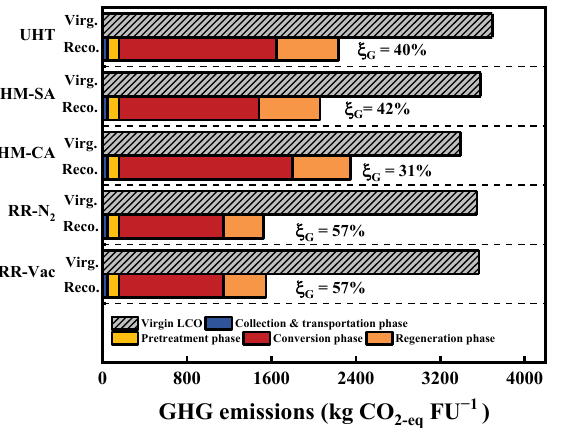
Figure 7. Contribution analysis of total GHG emissions for the five different recycling methods. Each pair of bars represents a method, where the bottom bar indicated the GHG emissions distribution of each phase for 1 FU, the top bar is the GHG emissions for producing an equivalent weight virgin LCO in industry, and the difference represents the GHG emission reduction. The numbers indicate the reduction rate of GHG emission for each method.